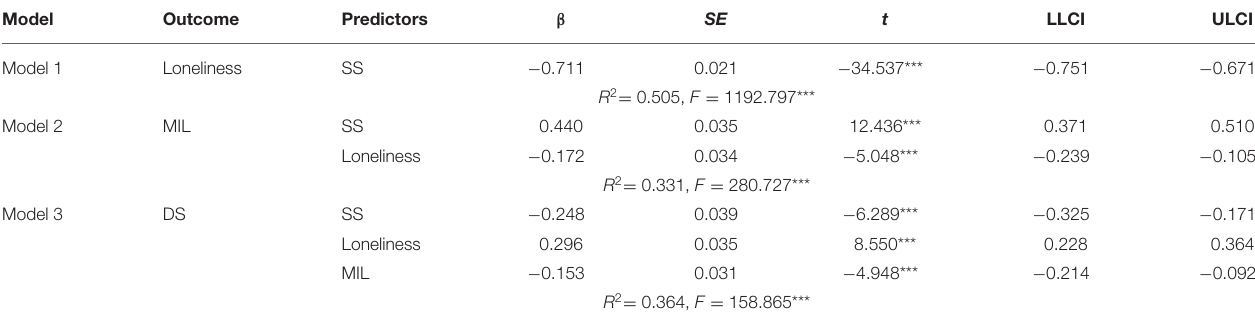
TABLE 3 | Regression analysis results.